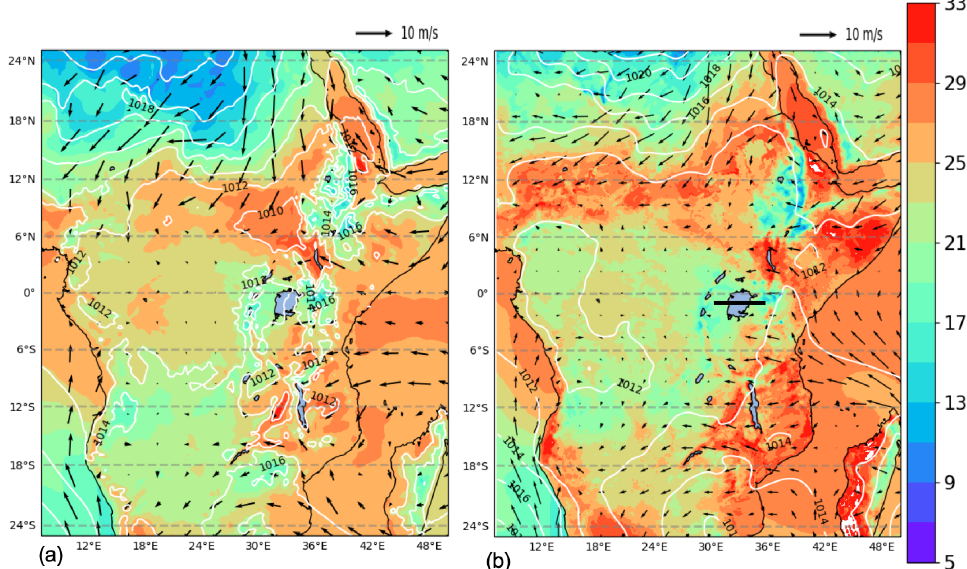
Figure 8. Mean sea level pressure (mslp) (hPa) (white contour lines), surface temperature (color shading) ( ◦ C) and 100m wind (black arrows) averaged over the period 25 November, 00:00UTC–1 December, 00:00UTC, by ERA5 reanalysis (a) and RegCM 12km (b) . The black line (b) shows the cross-section position represented in Fig. 9.